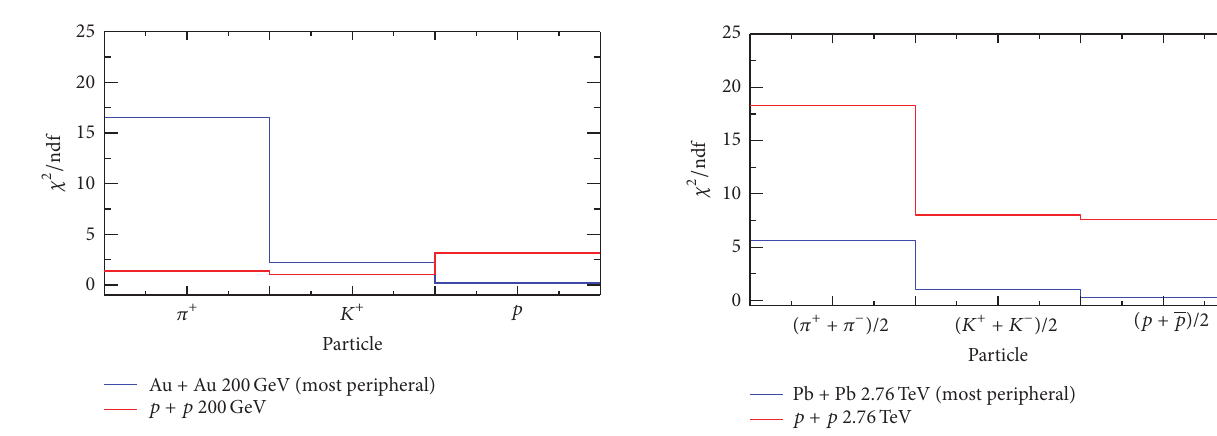
Figure 8: 𝜒 2 / ndf values are shown for most peripheral Pb + Pb collisions and 𝑝 + 𝑝 collisions at √𝑠 NN = 2.76 TeV using (8) as a fit